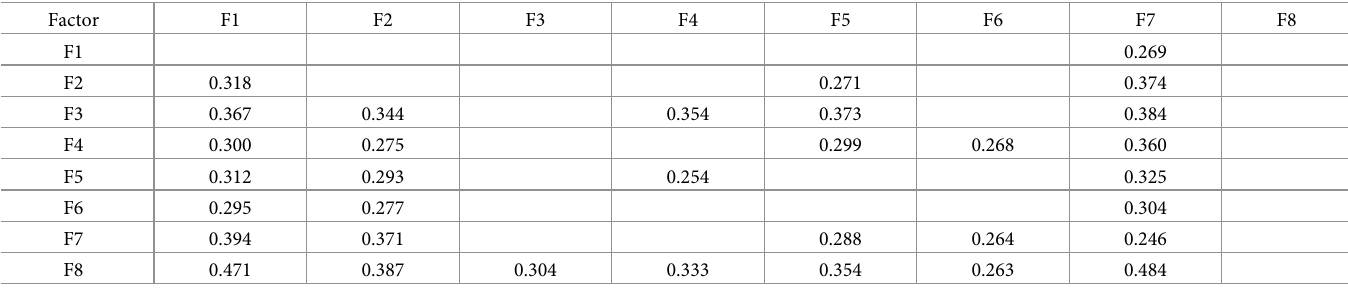
Table 6. Matrix T’ —Reduced form of the total—Influence matrix at a threshold value θ